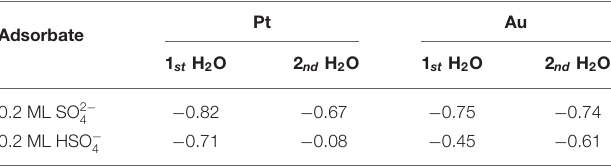
TABLE 2 | Water adsorption energies with respect to bulk water on Pt(111) and Au(111) covered by 0.2 ML of sulfate or bisulfate. Pt Au Adsorbate